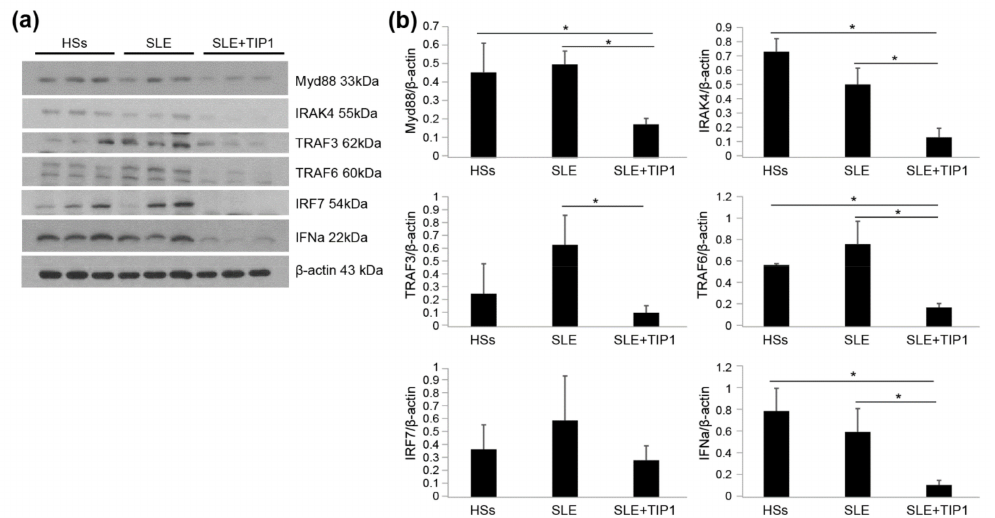
Figure 6. Inhibition of the Toll-like receptor (TLR) signaling pathway in peripheral blood mononuclear cells (PBMCs) of patients with systemic lupus erythematosus (SLE). ( a ) The expression of the proteins related to the TLR signaling was analyzed by Western blotting using PBMCs from patients with SLE (n = 3) and healthy subjects (HSs; n = 3). All 3 SLE patients were taking hydroxychloroquine 200 mg/d or 300 mg/d. Two SLE patients were not taking corticosteroids except one SLE patient taking prednisolone 2.5 mg/d. ( b ) Western blot data were quantified using a densitometer (* p < 0.05, Mann–Whitney U test). The experiments were repeated at least twice. TIP1, Toll-like receptor inhibitor peptide 1; MyD88, myeloid differentiation factor 88; IRAK4, interleukin-1 receptor-associated kinase 4; TRAF3, tumor necrosis factor receptor- associated factor 3; TRAF6, tumor necrosis factor receptor-associated factor 6; IRF7, interferon regulatory factor 7; IFN- α , interferon- α